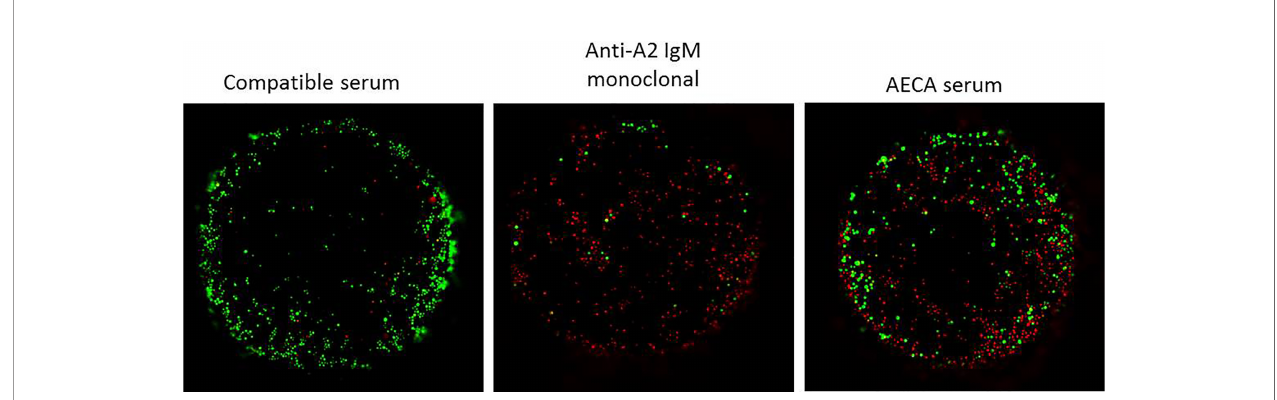
FIGURE 5 | Complement-dependent endothelial cytotoxicity using machine perfusion-derived primary renal endothelial cells (MP-PRECs) and pre-transplant patient serum. A representative experiment of a complement-dependent endothelial cytotoxicity crossmatch assay (CDC) using MP-PRECs (HLA typing A1, A2, B7, B8, Bw6, Cw7, DR15, DR11, DR51, DR52, DQ6, DQ7, and bloodgroup A, incubated with blood group-compatible serum, a monoclonal antibody directed against A2 IgM, and the AECA-positive patient serum. Rabbit complement was used as the complement source. Living cells are depicted in green and apoptotic cells in